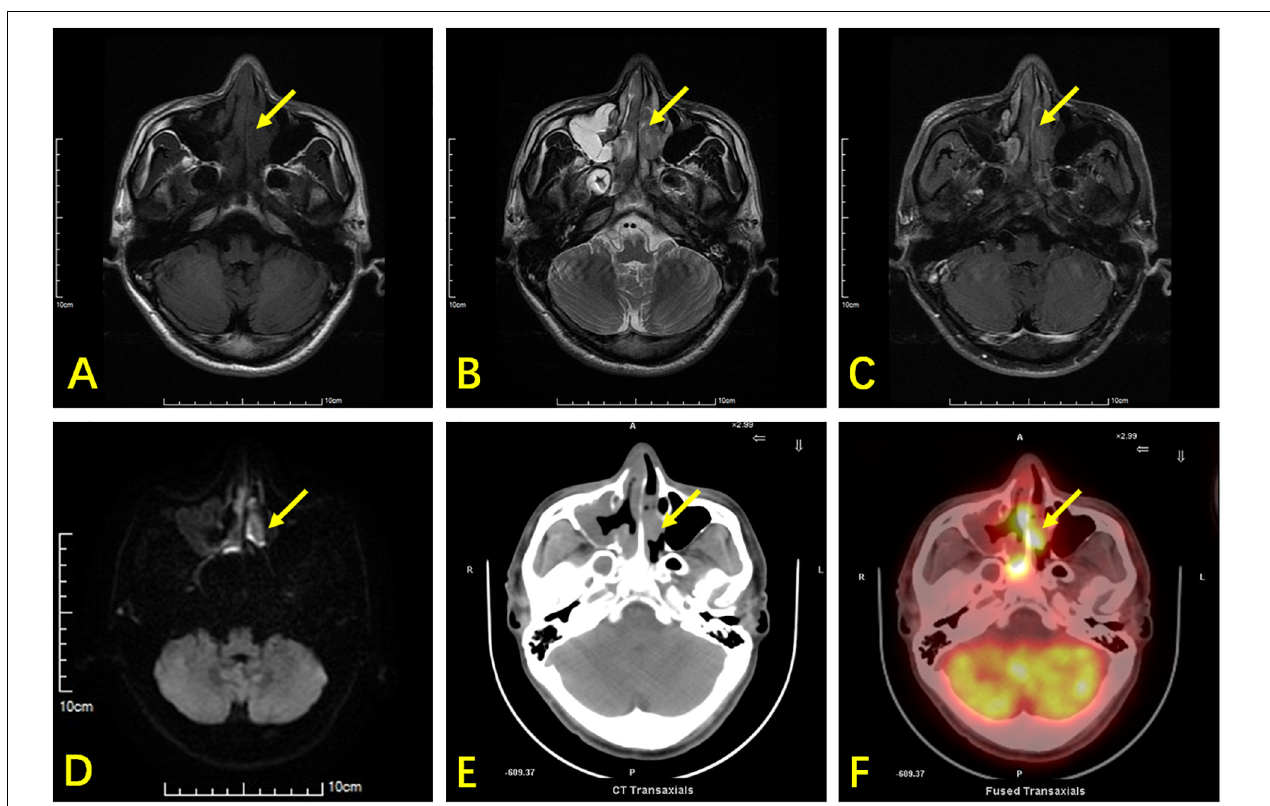
FIGURE 1 | A 42-year-old man with ENKTL presented with nasal obstruction. (A) Axial section T1WI shows an isointense soft-tissue mass (arrow) in the nasal cavity and nasal septum. (B) Axial section T2WI shows the abnormal tissue as heterogeneously hyperintense. (C) Contrast-enhanced T1WI showing heterogeneous enhancement of tumor tissues. (D) DWI shows limited lesion diffusion. (E) Axial CT shows a soft tissue mass and nasal septum destruction. It was difficult to distinguish the soft tissue mass from inflammatory thickening of the mucosa in the right maxillary sinus using CT. (F) 18 F-FDG PET/CT shows high glucose metabolism in the nasal cavity lesion, while low glucose metabolism is observed in the mucosa of the right maxillary sinus. The nasal cavity lesion was suspicious of tumor in both MRI and PET/CT, while the right maxillary sinus lesion was suspicious of inflammation.